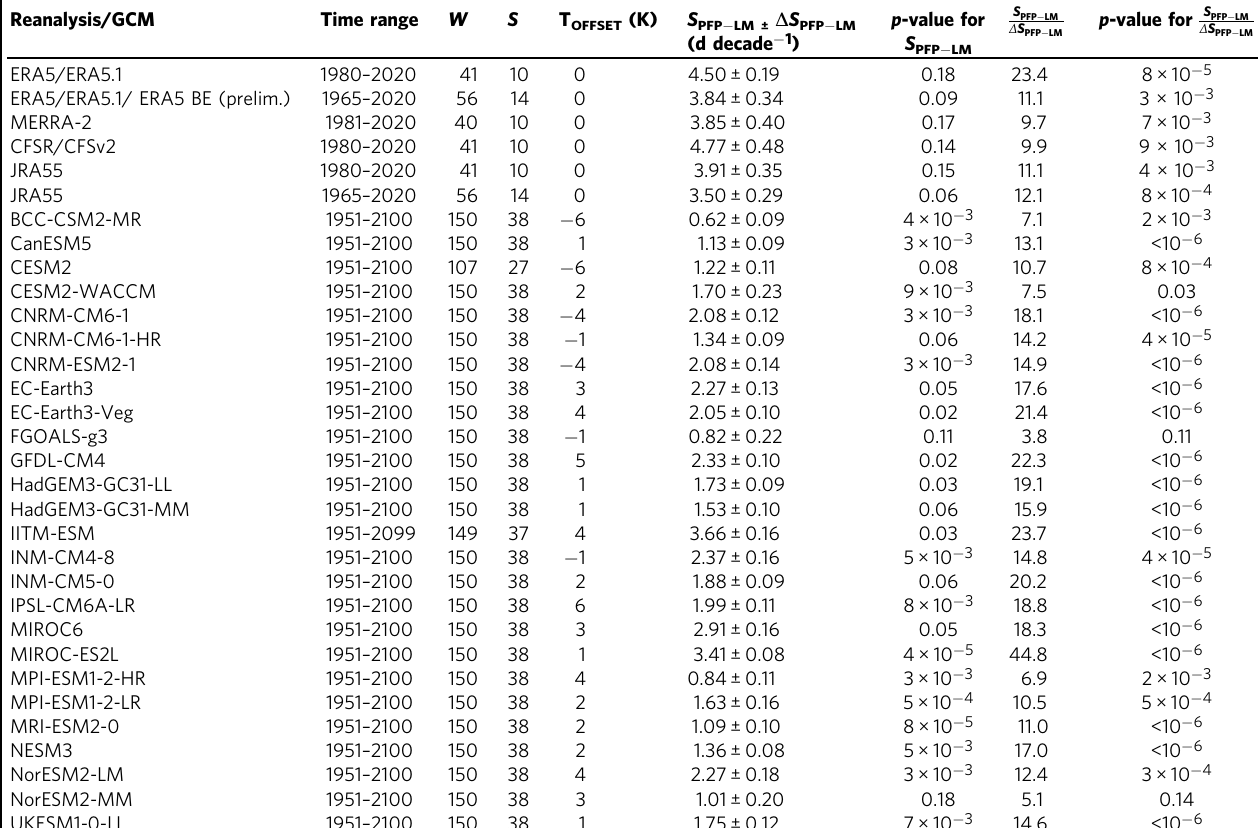
Table 1 PFP LM trend results for the reanalyses and CMIP6 GCM output.